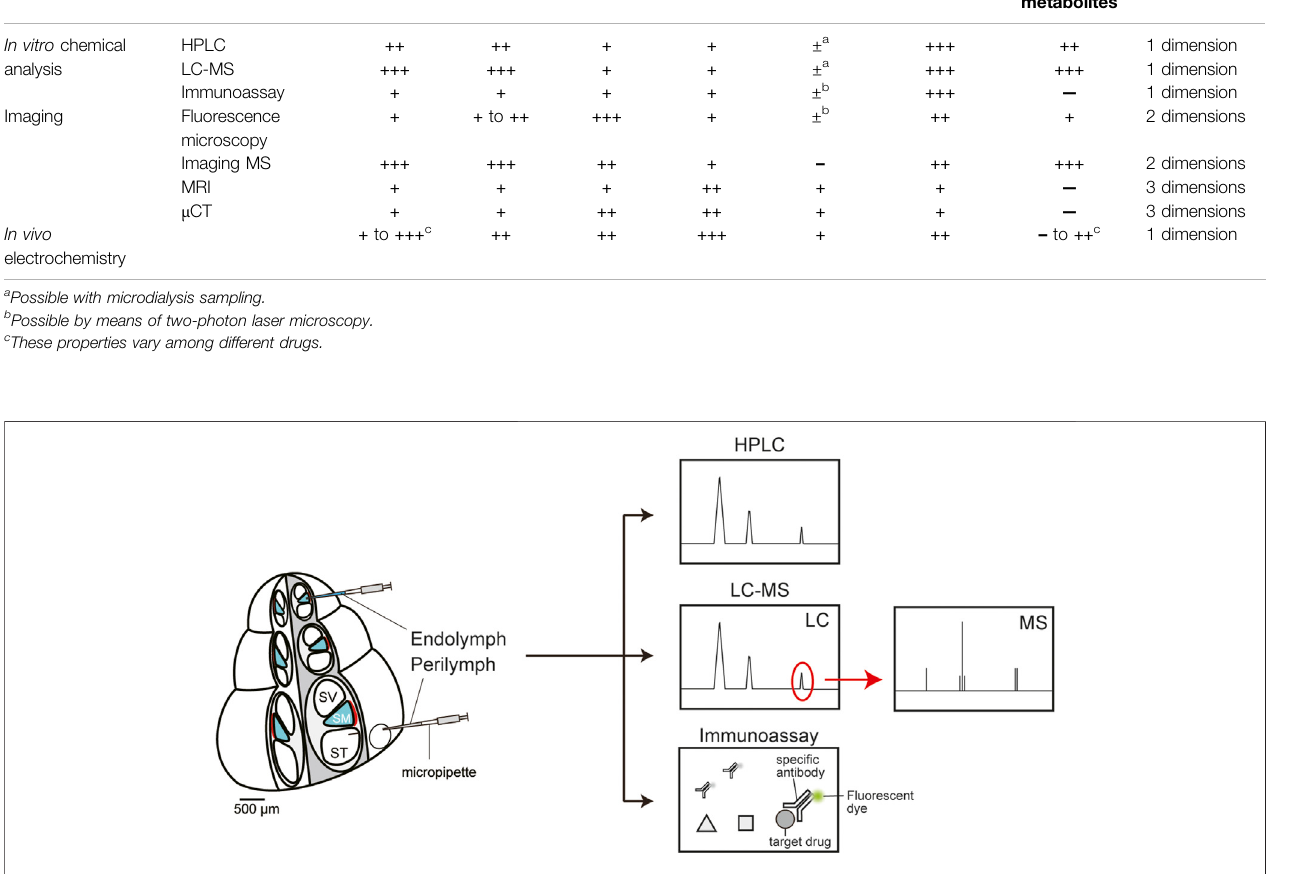
TABLE 1 | Comparison of pro fi les of different drug detection methods. Method categories